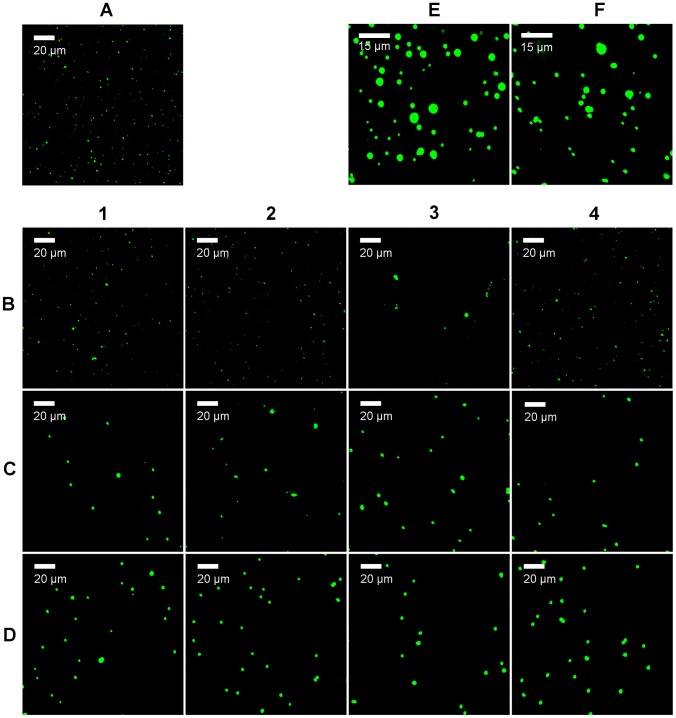
Extent of particle aggregation in PBS.CLSM images of original uncoated nanoparticles (A), coated nanoparticles with PLL/DES at pH 4 (B1-B4), with PLL/DES at pH 9 (C1-C4), and with PAH/PSS without pH adjustment (D1-D4). The numbers indicate the number of layers. Larger, uncoated particles at ∼2 μm (D) with their coated counterparts at 4 layers (E) are without aggregation.